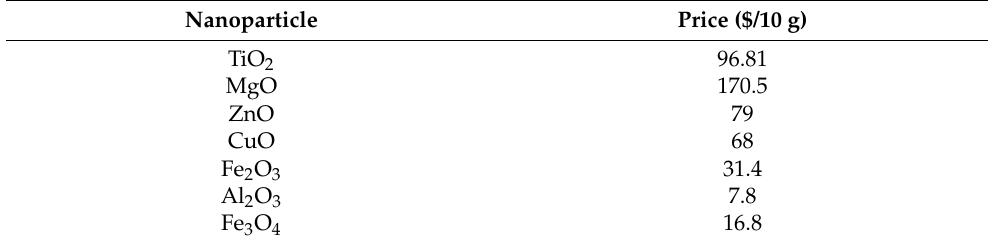
Table 5. Price of some oxide-based nanoparticles